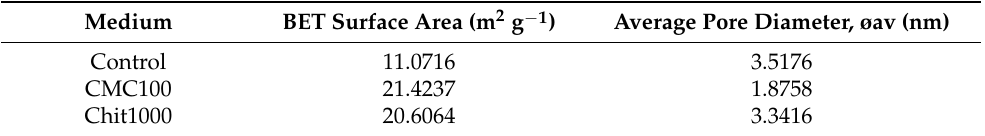
Table 3. Nitrogen porosimetry for surface area and pore size measurements, using the BET ap- proach, of the control and CMC100 and Chit1000 media. BET: Brunauer–Emmett–Teller;